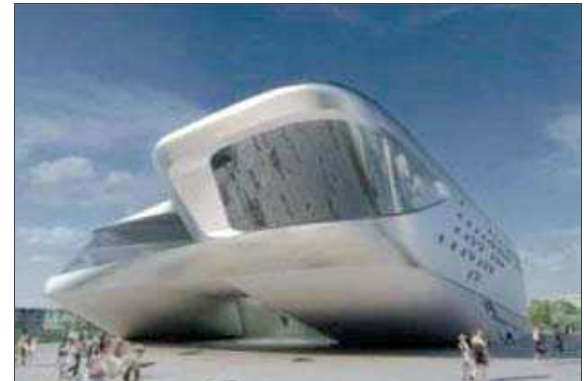
Fig. 14. the present favourite field of Vilnius citizens in the centre of the city